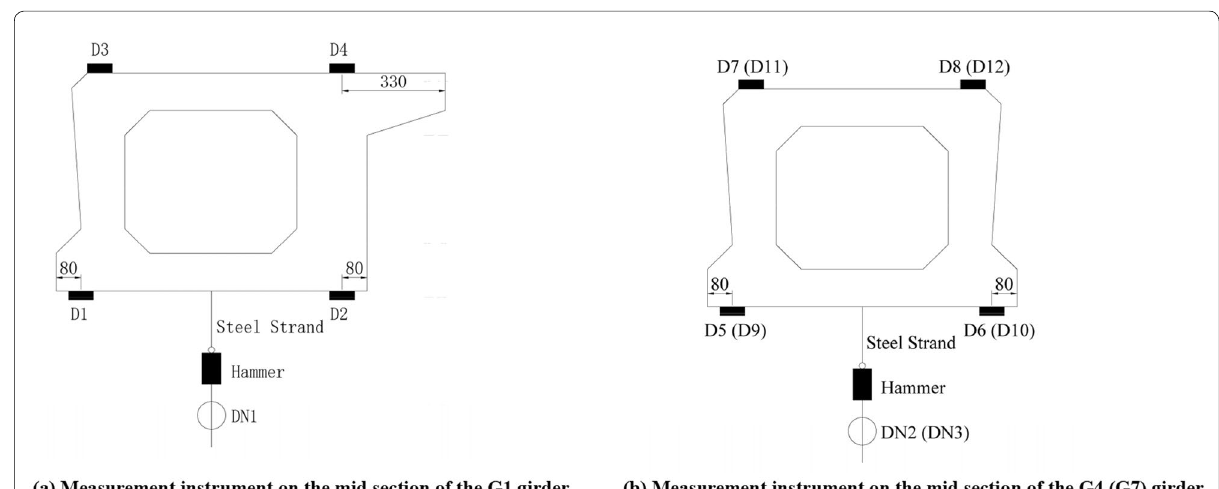
Fig. 5 Measurement instrument position (units: mm). Note: Di: strain gauges; DNi: deflection